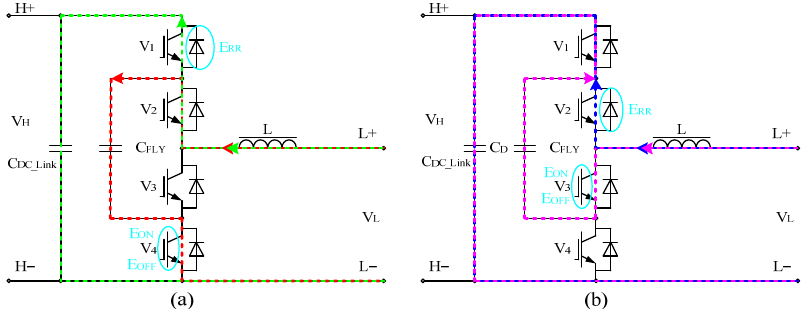
Figure 4. Commutation paths of FC ‐ 3L ‐ BDC. ( a ) Buck mode, 0.5 < D < 1 (V 1 switching). ( b ) Buck mode, 0.5 < D < 1 (V 2 switching).